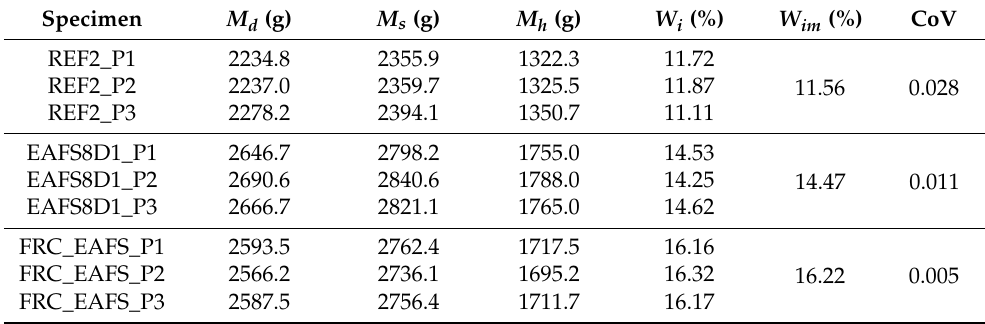
Figure 6. Set-up of water absorption test by immersion: ( a ) at atmospheric pressure; ( b ) under vacuum. Table 11. Results of water absorption test by immersion at atmospheric pressure for the REF2 mixture and for the mixtures with EAFS and RTSF.